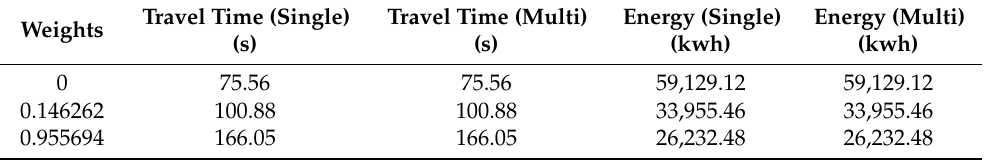
Figure 6. Comparison of multi-weighted and single-weighted DP results.